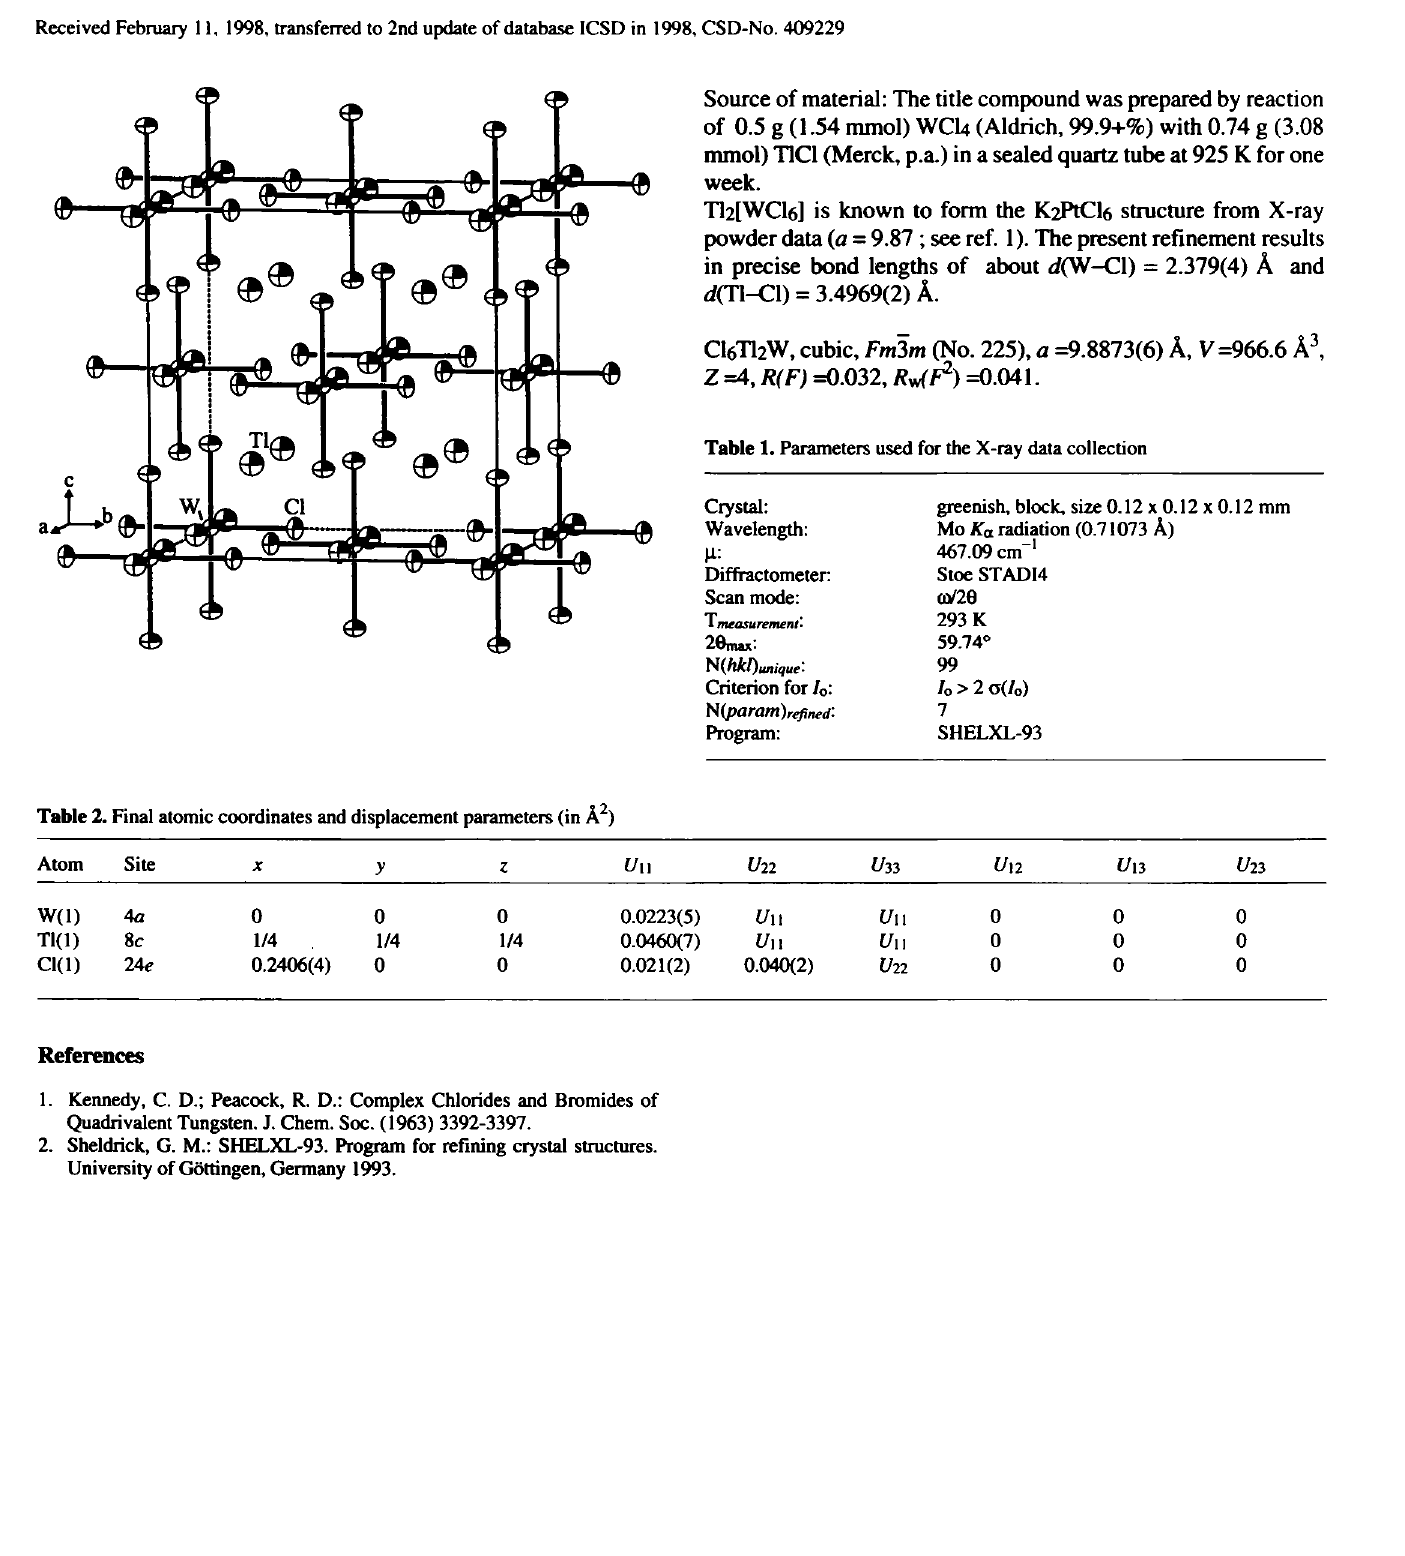
Table 1. Parameters use.d for the X-ray data collection Crystal: